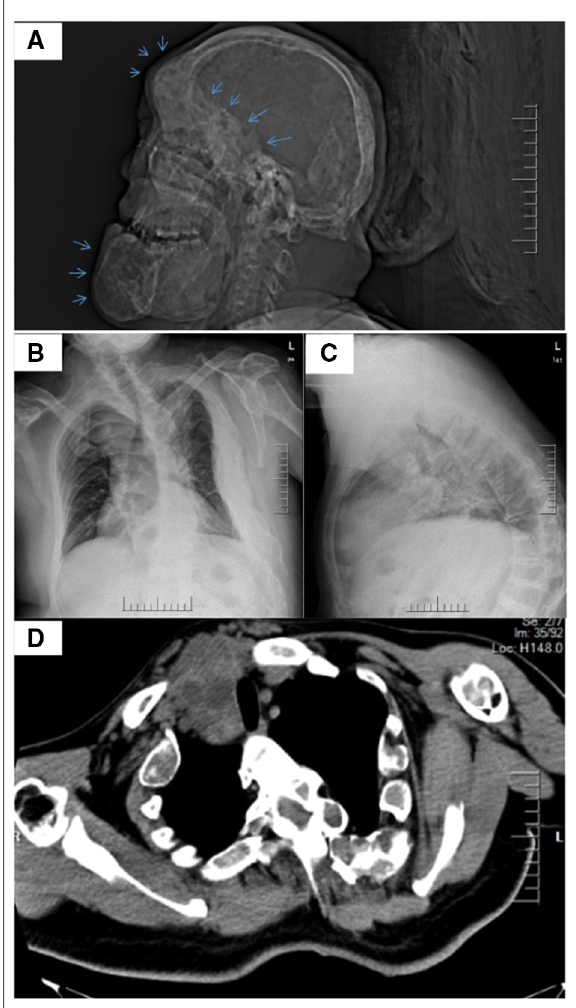
FIGURE 2 Radiographic features of the patient before surgery demonstrating fi brous dysplasia and an enlarged thyroid. The lateral skull radiograph acquired from a CT ( A ) indicates polyostotic fi brous dysplasia on the head (blue arrows). X-ray from the patient ( B,C ) shows thoraco-lumbar scoliosis. CT image of patient upper chest ( D ) demonstrates the enlarged retrosternal